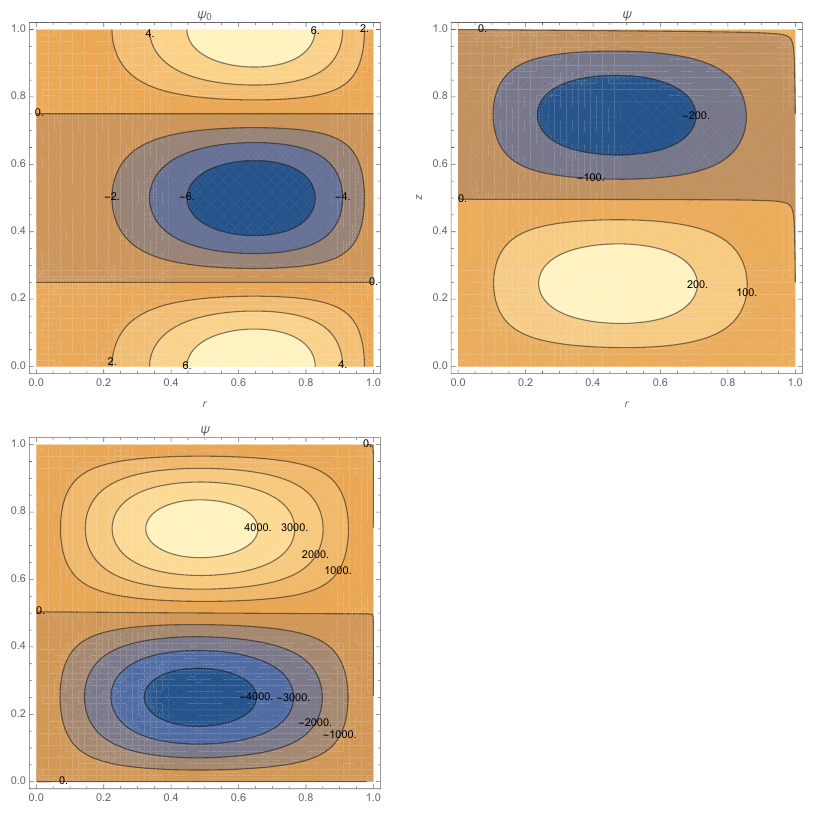
Figure 5. Study of the perturbation for λ = 7.3, i.e., not in the resonance region: ψ 0 ( upper left panel ); ψ for α = 0.001 ( upper right panel ) and 0.01 ( bottom panel ). The contribution of ψ 1 is visible to become larger than the contribution of ψ 0 and, therefore, the linear approximation is not valid above α =